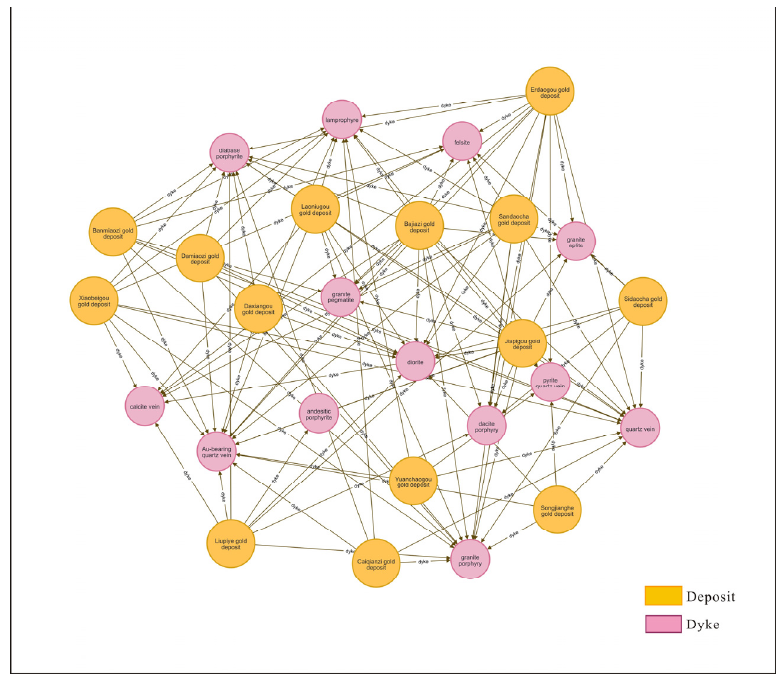
Figure 9. A subgraph for the dykes and ore deposits.